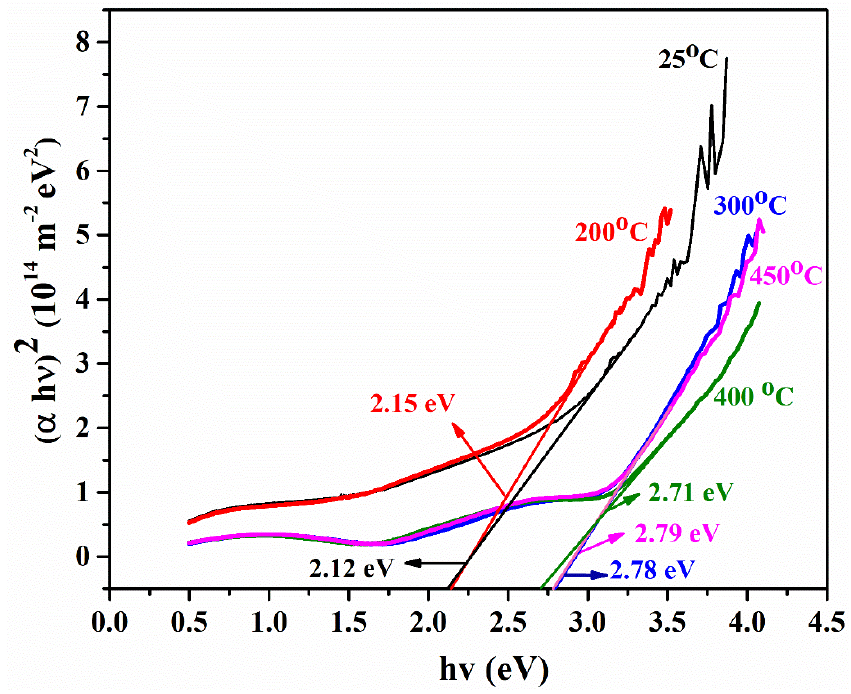
Figure 6. Band gap of PbS thin film at 25 ◦ C, 200 ◦ C, 300 ◦ C, 400 ◦ C, and 450 ◦ C. The conductivity of as-deposited and annealed PbS films at 200 ◦ C, 300 ◦ C, 400 ◦ C, and 450 ◦ C were found to be 5.45 × 10 − 4 , 2.25 × 10 − 5 , 1.47 × 10 − 5 , 1.85 × 10 − 4 , and 1.21 × 10 − 5 S/m, respectively. The conductivity of the as-deposited sample is